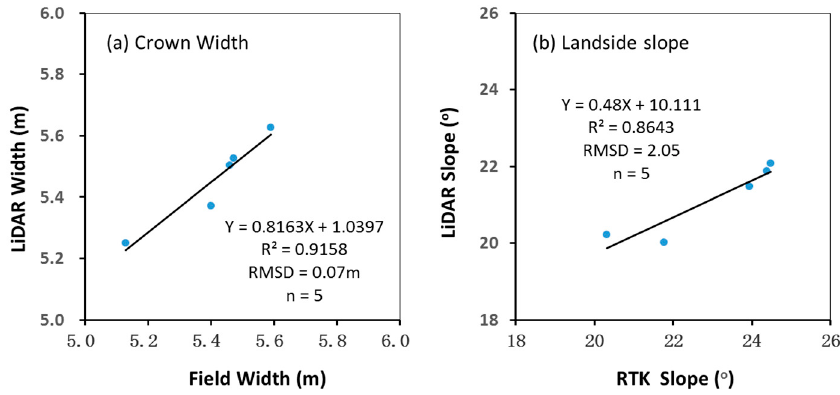
Figure 7. Scatter plots of the script-extracted levee crown width and landside slope against the field measured values using meter cord and RTK in levee A.